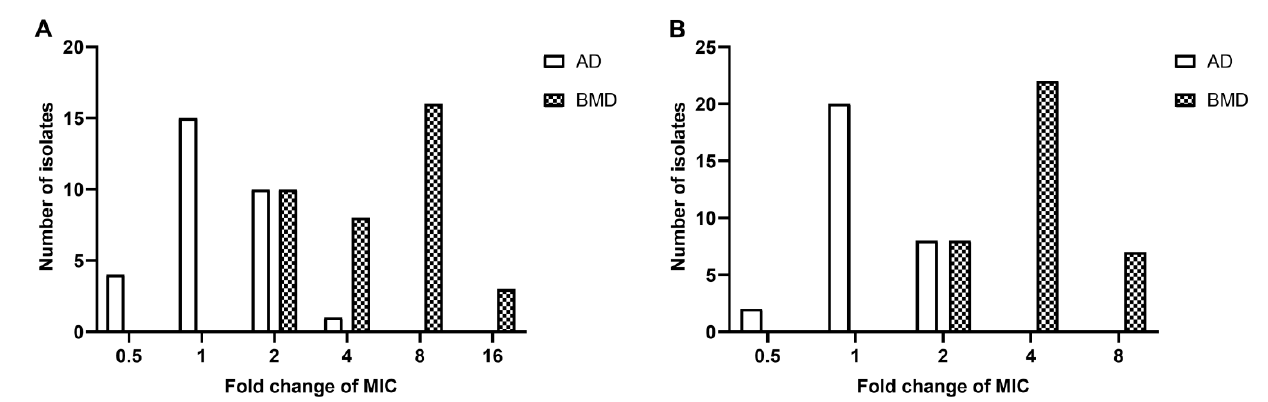
Figure 2. Comparison of MIC values for polymyxin B ( A ) and colistin ( B ) using polystyrene and glass plates. Fold change of MIC means the ratio of the MIC values obtained from polystyrene to those obtained from glass plates (AD: non-tissue-culture-treated plates vs. glass plates; rBMD: tissue-culture-treated microtiter plates vs. glass-bottom microtiter plates).